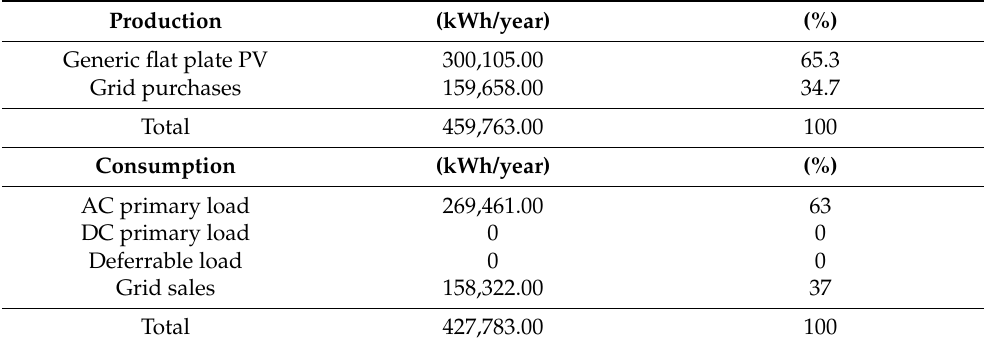
Figure 10. ( a ) Energy purchased from grid and ( b ) energy sold to grid. The calculation shows that the share of renewable energy sources from photovoltaic panels is 65.3% (Table 8). Table 8. Production and consumption of electrical energy.